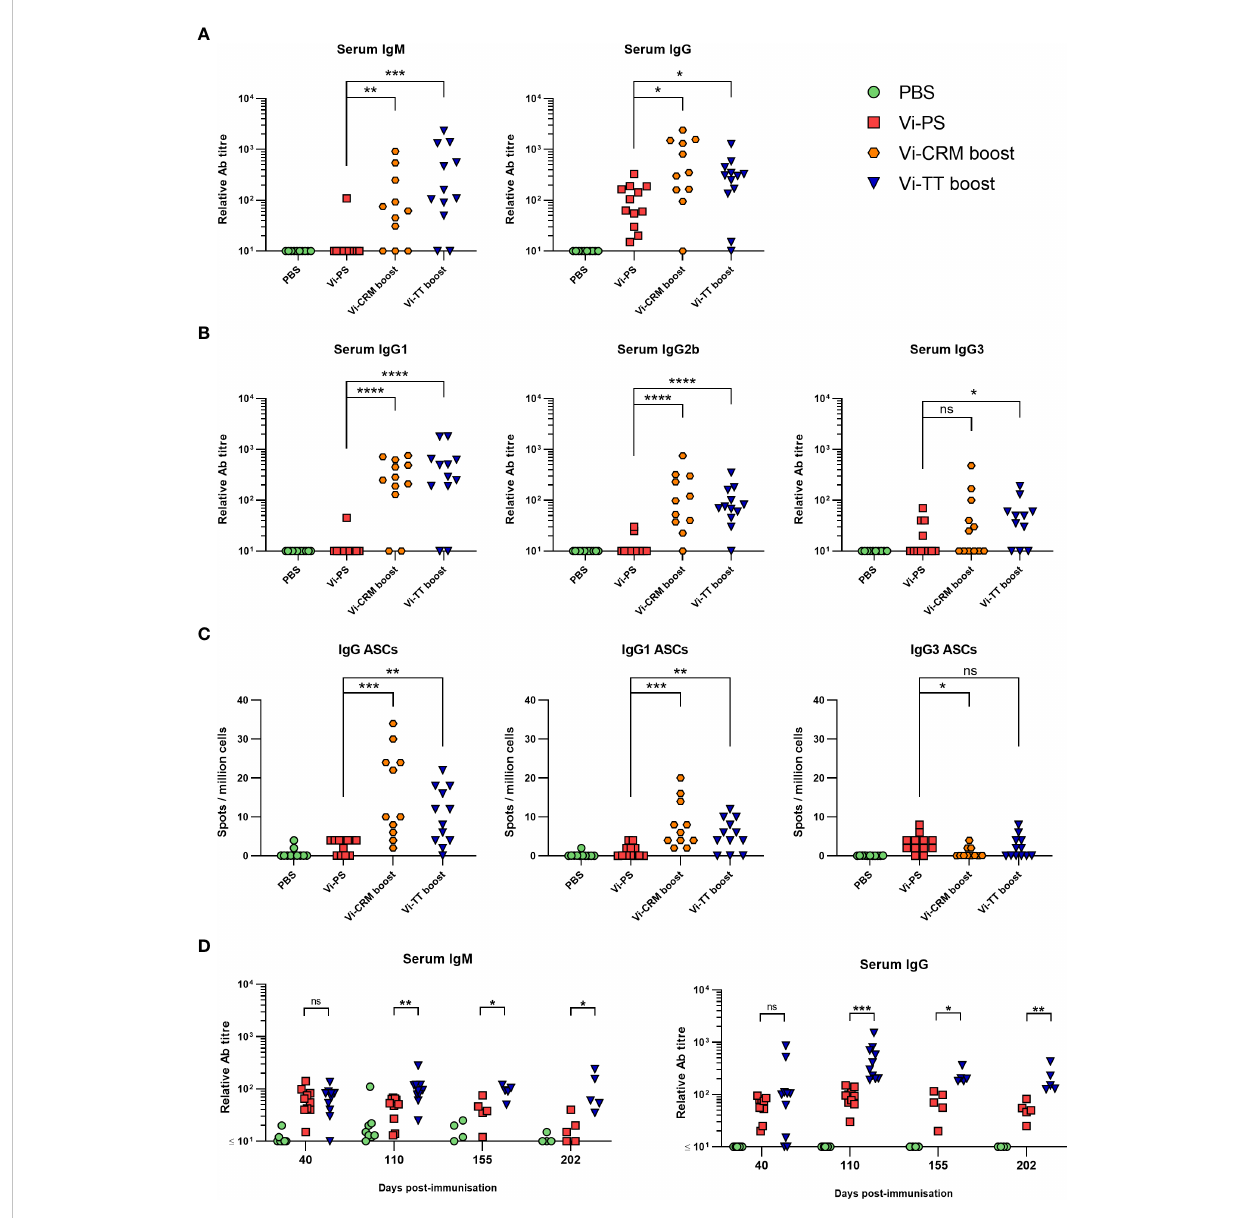
FIGURE 5 Antibody responses to Vi-PS and TCVs over time. C57Bl/6 mice were immunized i.p with PBS, 4 µg Vi-PS on day 0, or 2 µg of Vi-CRM 197 or Vi-TT on both day 0 and 35. Serum was collected day 185 (6 months post-primary immunization). Sera were assessed by ELISA for (A) anti-Vi IgM and IgG and (B) isotypes IgG1, IgG2b or IgG3. (C) Bone marrow anti-Vi IgG, IgG1 and IgG3 antibody secreting cells (ASCs) at the 6-month timepoint were enumerated by ELISPOT. (D) C57Bl/6 mice were immunized i.p with 4 µg Vi-PS or PBS on day 0, or 2 µg Vi-TT at both day 0 and 35. Serum